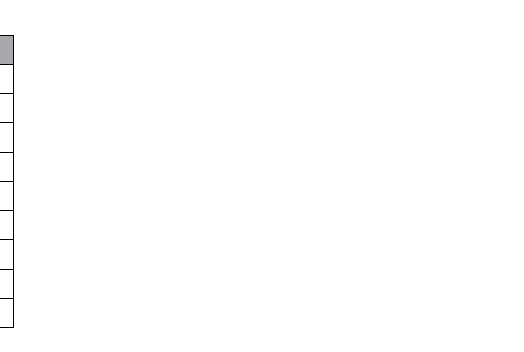
Table 5. Some of the selected bond angles and bond lengths for 6b